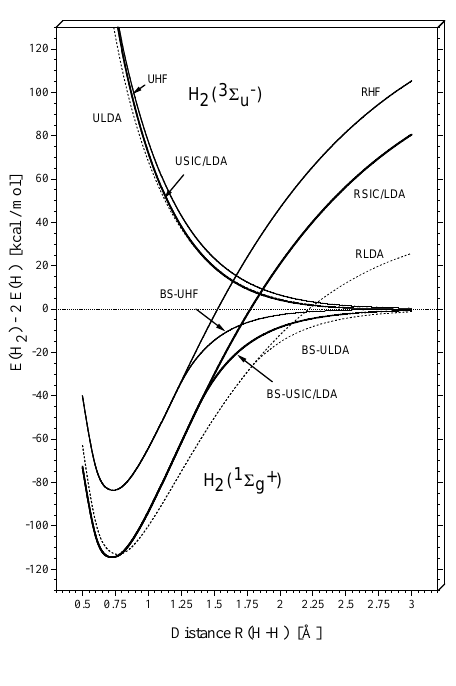
Figure 1: Potential curves of the 1 Σ + basis set at various levels of